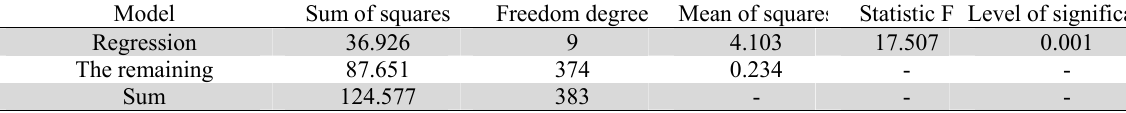
Linear relation between criterion and predictor variables Model Sum of squares Freedom